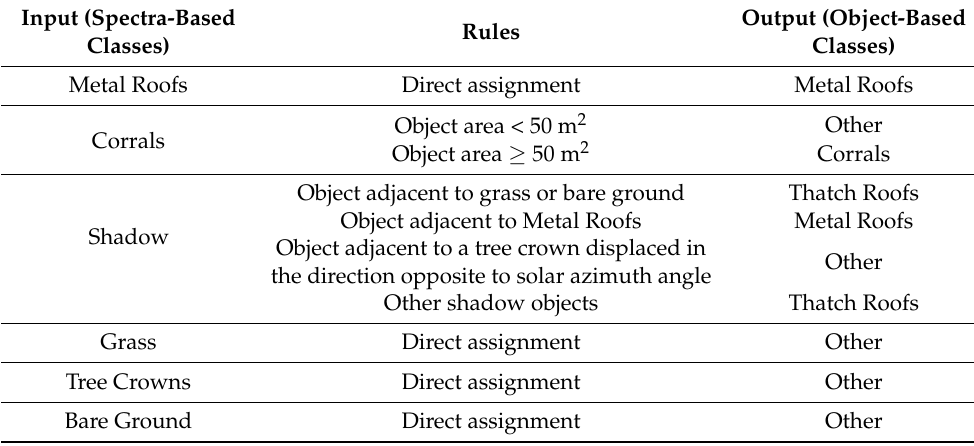
Table 3. Rules that were implemented during the object-based classification stage. The rules for the shadow class are executed in the listed order.